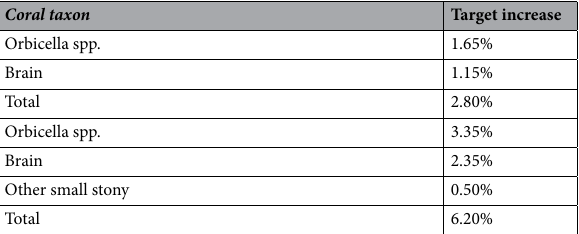
Table 3. Percent increases in absolute coral cover in patch reef habitat at Cheeca Rocks based on the targets for Mission: Iconic Reefs used to project the impacts of restoration on habitat persistence (NOAA 2021). The aim is to increase coral cover by a total of 9% over 2 restoration phases spanning over 20 years. Phase 1 consists in increasing absolute coral cover by a total of 2.8% over approximately 10 years starting in 2022 and phase 2 involves increasing cover by an additional 6.2% in the following 10